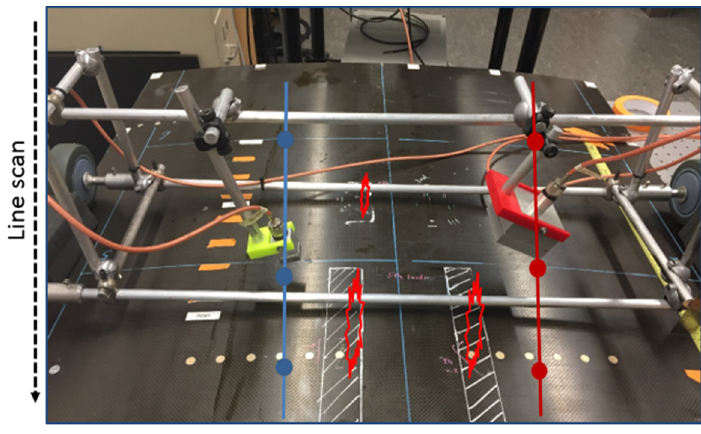
Figure 7. The non-contact air-coupled scanning prototype mounted on Test Panel 3.